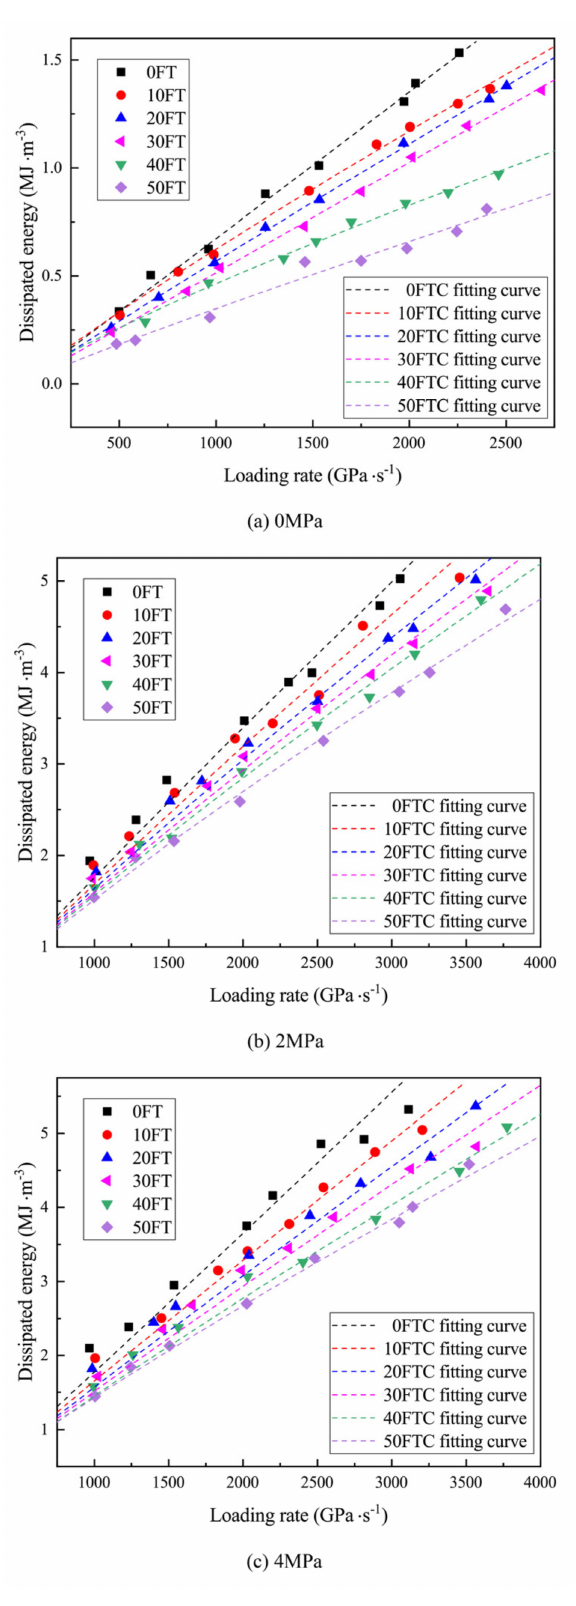
Figure 12. Dissipated energy of specimen and fitting curves of FT cycling-treated specimen subjected to different hydrostatic pressures: ( a ) 0 MPa; ( b ) 2 MPa; and ( c ) 4